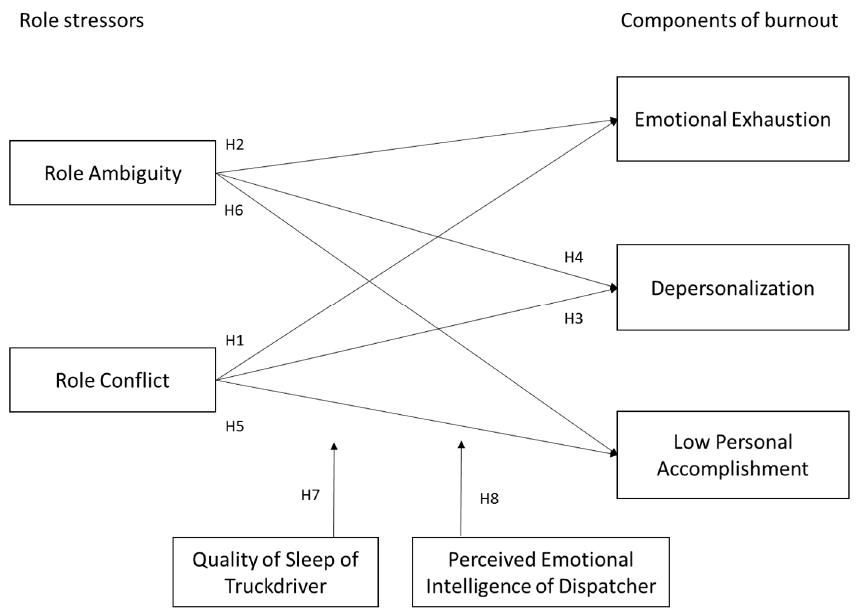
Figure 1. Conceptual model.